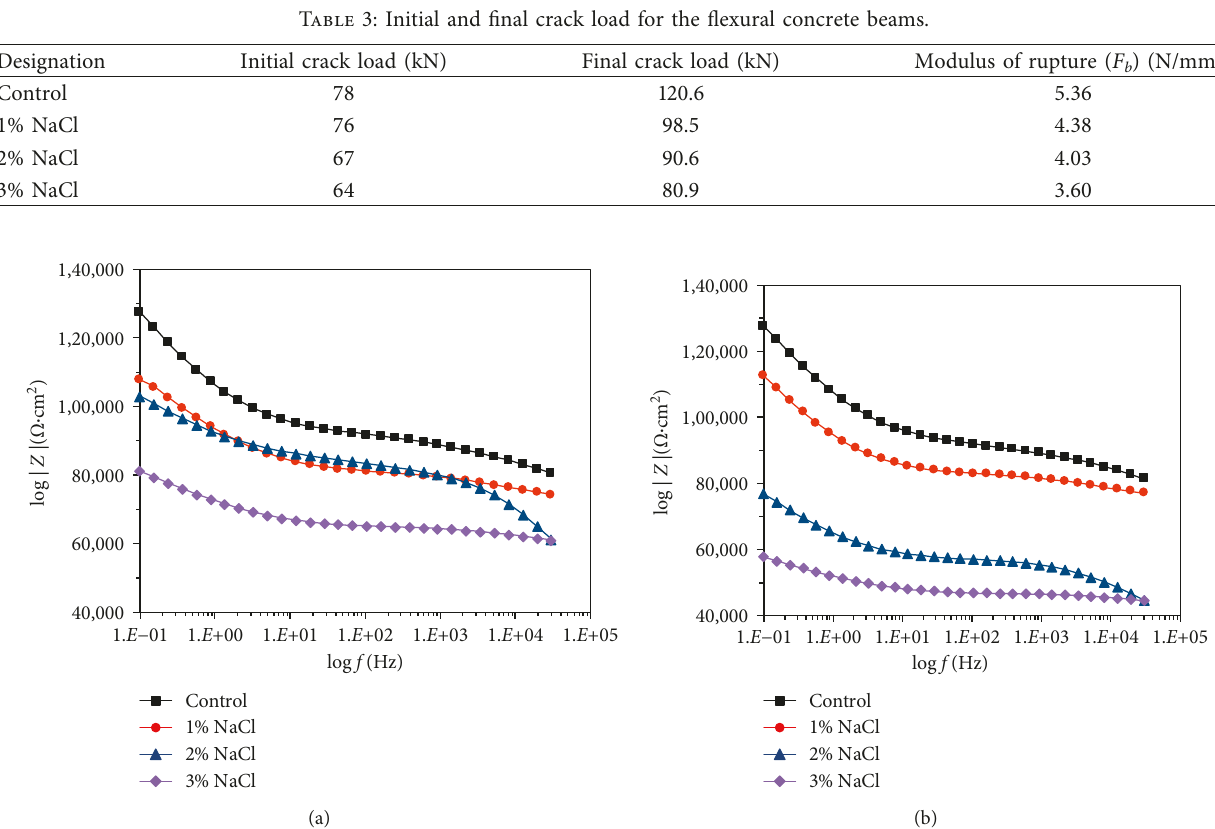
Figure 9: Impedance modulus curve for the rebar (a) and prestressed steel (b) in chloride-contaminated